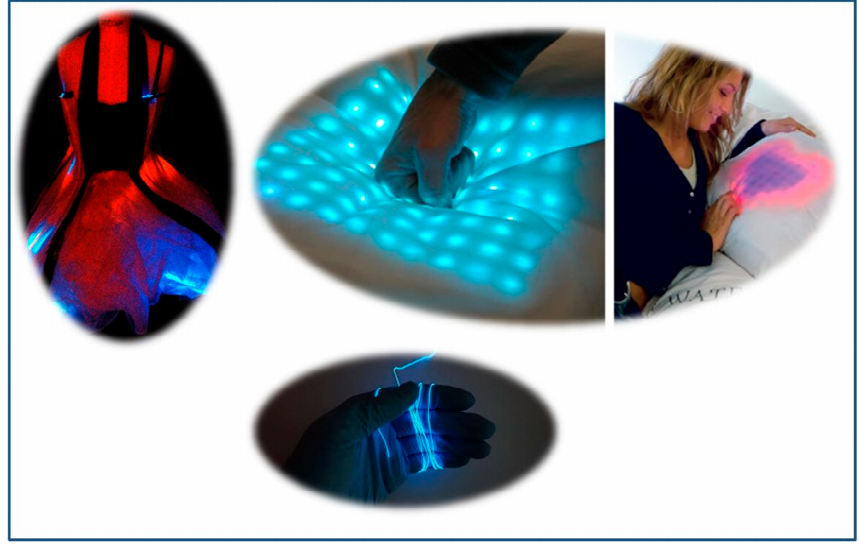
Figure 12. Some examples of wearable electronic smart textiles. Images were taken from the Internet [23,62,63].